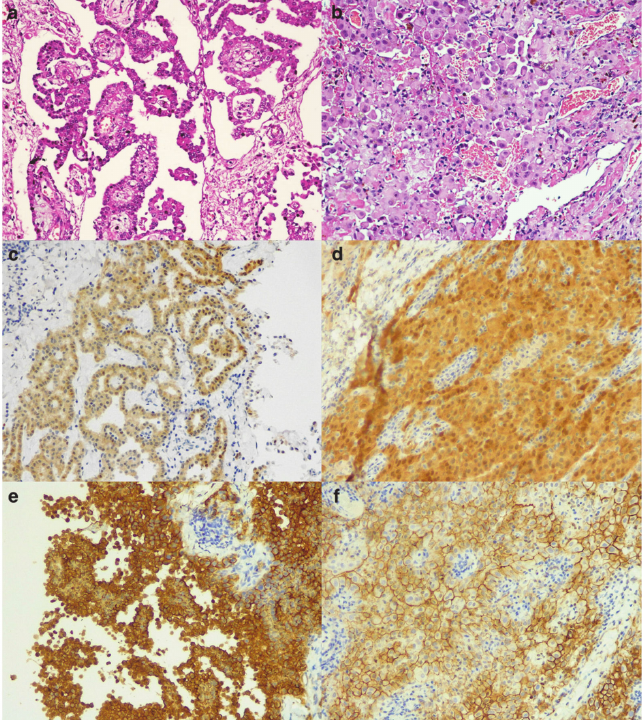
Figure 3. Case 3: Histological section of ovarian mesothelioma with papillary pattern (( a ) hema- toxylin and eosin stain, original magnification × 200) and diffusely immunoreactive calretinin (( c ) immunohistochemistry, original magnification × 200), and D2-40 (( e ) immunohistochemistry, original magnification × 200). Case 4: Histological section of ovarian mesothelioma with solid pattern and deciduoid cytology (( b ) hematoxylin and eosin stain, original magnification × 200) and diffusely immunoreactive calretinin (( d ) immunohistochemistry, original magnification × 200), and D2-40 (( f ) immunohistochemistry, original magnification ×